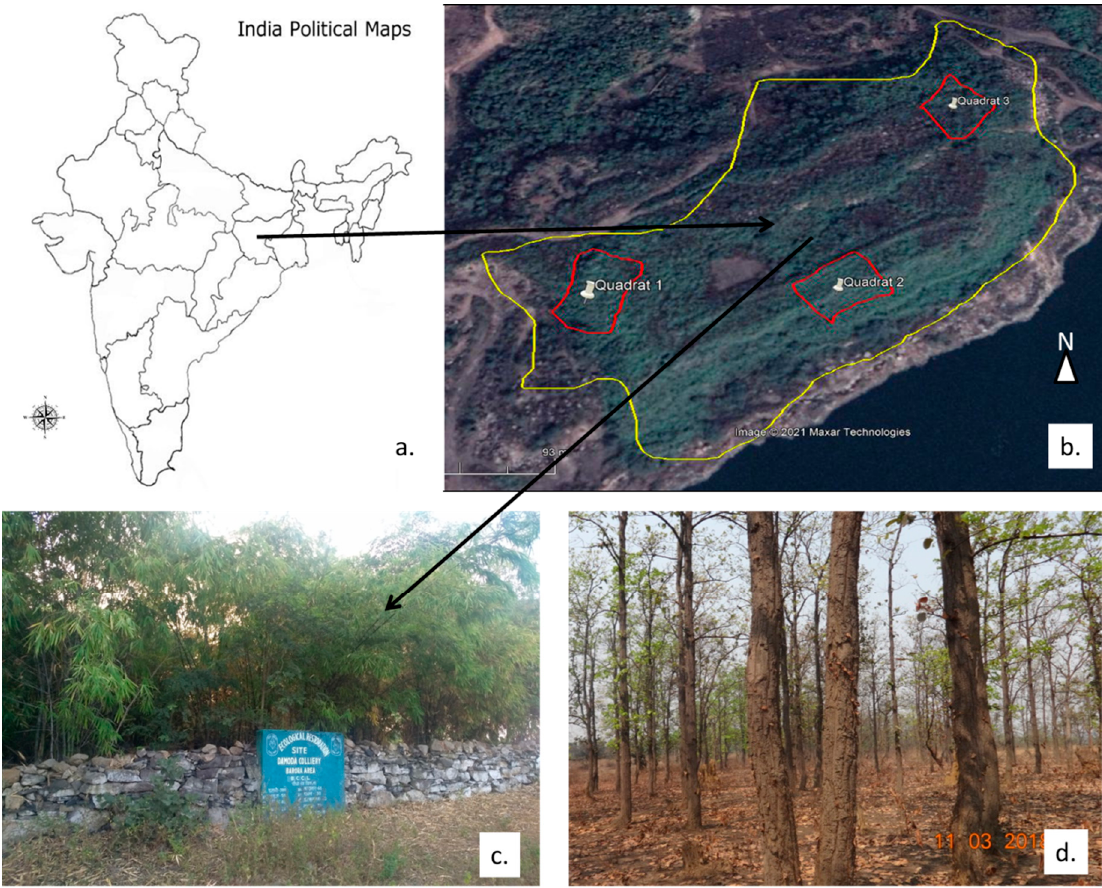
Figure 1. ( a ) Map of India, showing the Jharkhand state ( b ) Location map of Damoda ecorestoration site showing the 3 quadrats in the sampling area ( c ) Outer view of Damoda eco-restoration site showing dense bamboo cumps and stone boundry ( d ) Reserve forest sampling site.